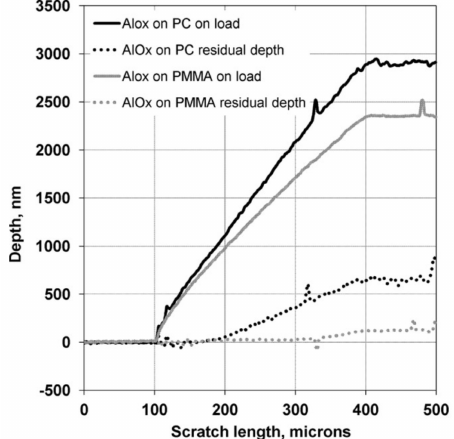
Figure 7. On-load and residual depth curves for Al 2 O 3 /PMMA and Al 2 O 3 /PC (polycarbonate) after the nanoscratch. The test was repeated five times per sample; each scratch had 500 µ m of length, at a scanning velocity of 10 µ m/s, and a ramped load varying from 0.1 mn to 60 mn (reprinted with permission from [53], Copyright 2012, American Vacuum